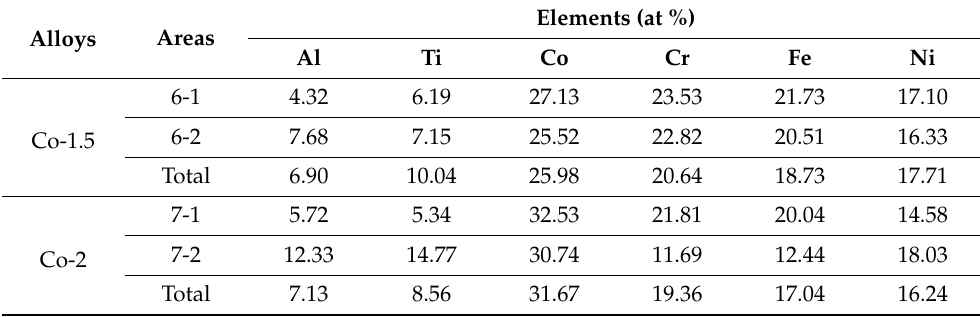
Figure 4. Microstructure and XRD results for Al0.5Co x CrFeNiTi0.5 HEAs: ( a ) Co-1.5 alloy, ( b ) Co-2 alloy; and ( c ) XRD results. Table 5. EDS results for Al0.5Co x CrFeNiTi0.5 HEAs.